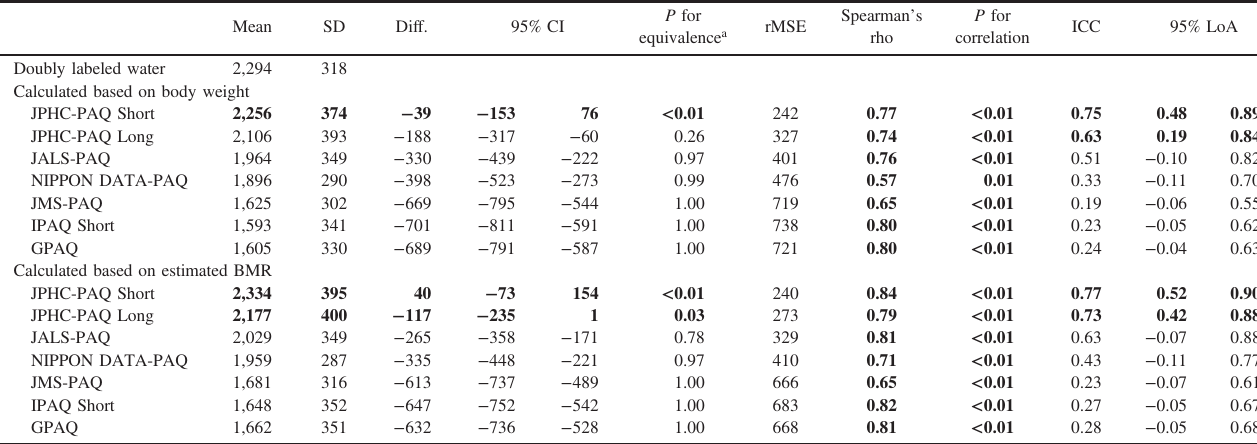
P for Spearman ’ s rMSE equivalence a rho